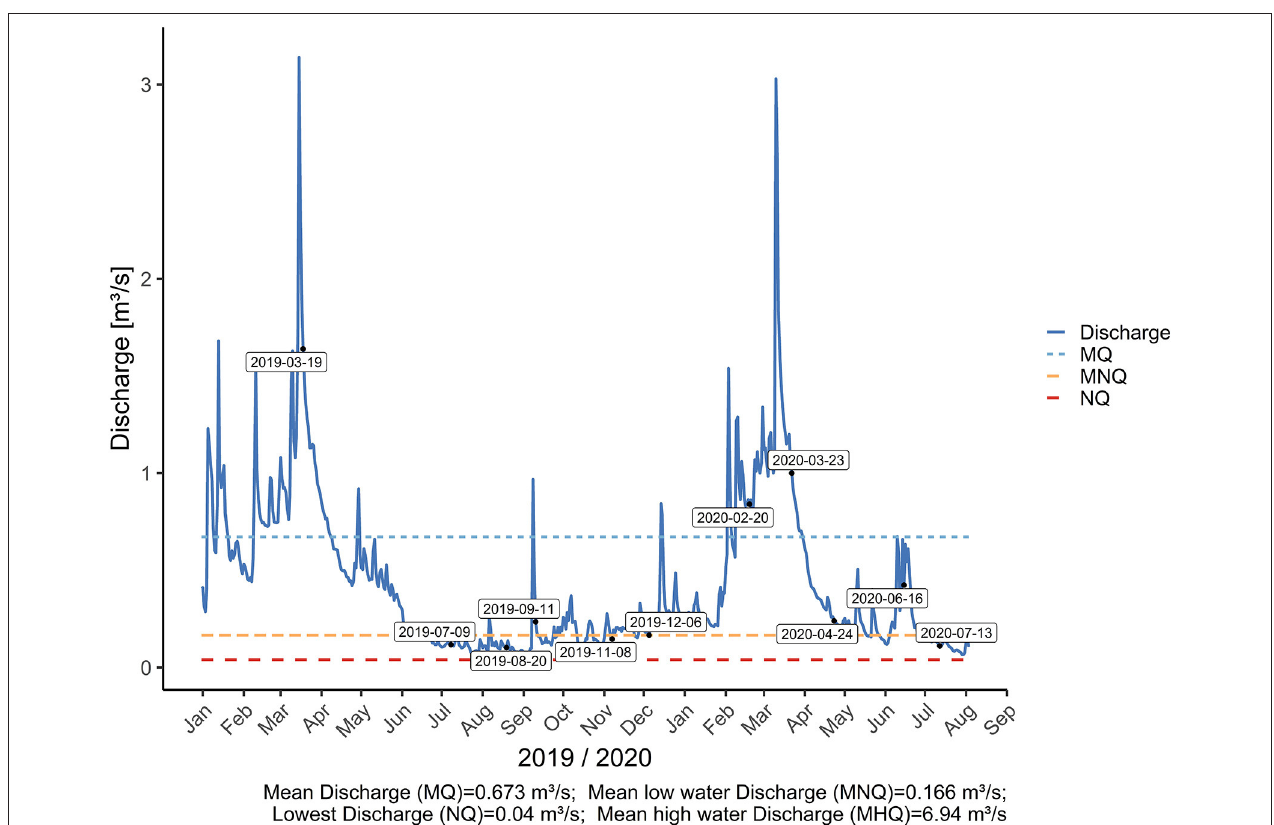
FIGURE 2 | Discharge and long-term discharge characteristics of the Mähringsbach at the water gauge Rehau. The blue dashed line shows the long-term average discharge at the gauge. The long-term low flow average is indicated by the orange dashed line. The red dashed line shows the long-term lowest discharge (lowest value of the last 30